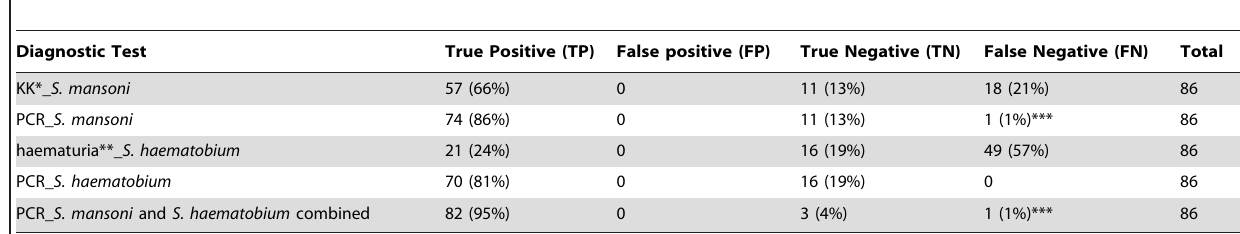
Table 1. Frequency of positive and negative infection for Schistosoma mansoni and S. haematobium infected people from Ghana evaluated by Kato-Katz (KK), haematuria and polymerase chain reaction (PCR).